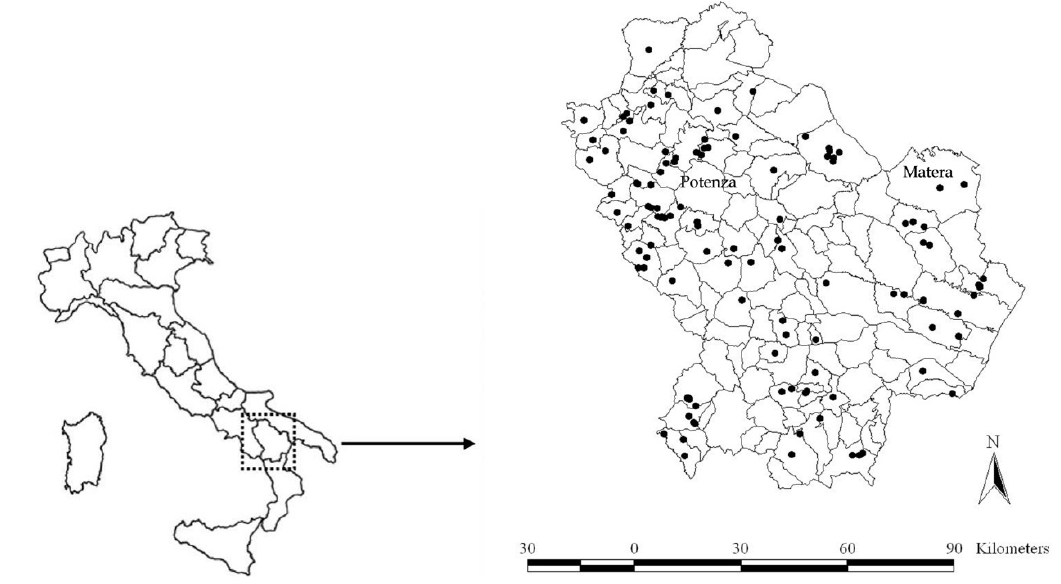
Figure 1. Location of the illegal dumpsites in the region of Basilicata